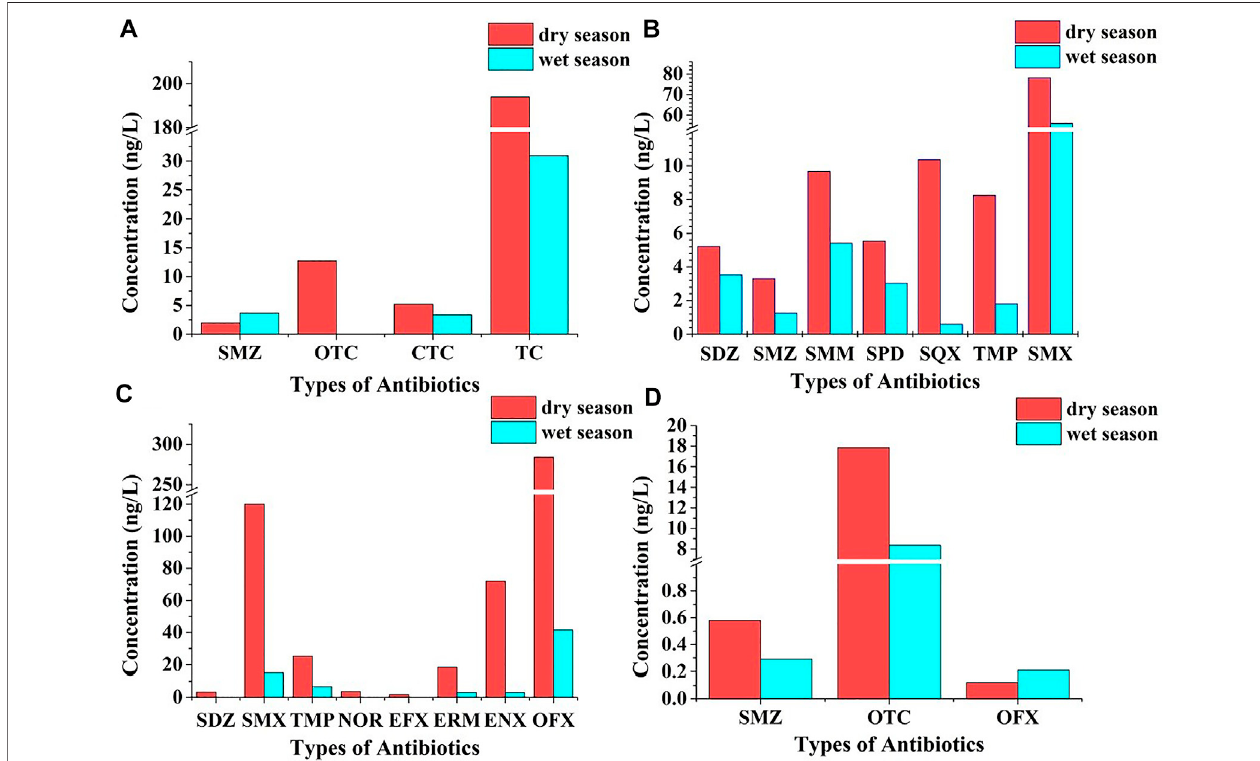
FIGURE 2 | Effect of abundant water period or dry water period on antibiotic concentrations in water bodies (A) : Huangpu River; (B) : Weihe Rive; (C) : Xiaoqinghe River (Shangdong); (D) : Taihu Lake.